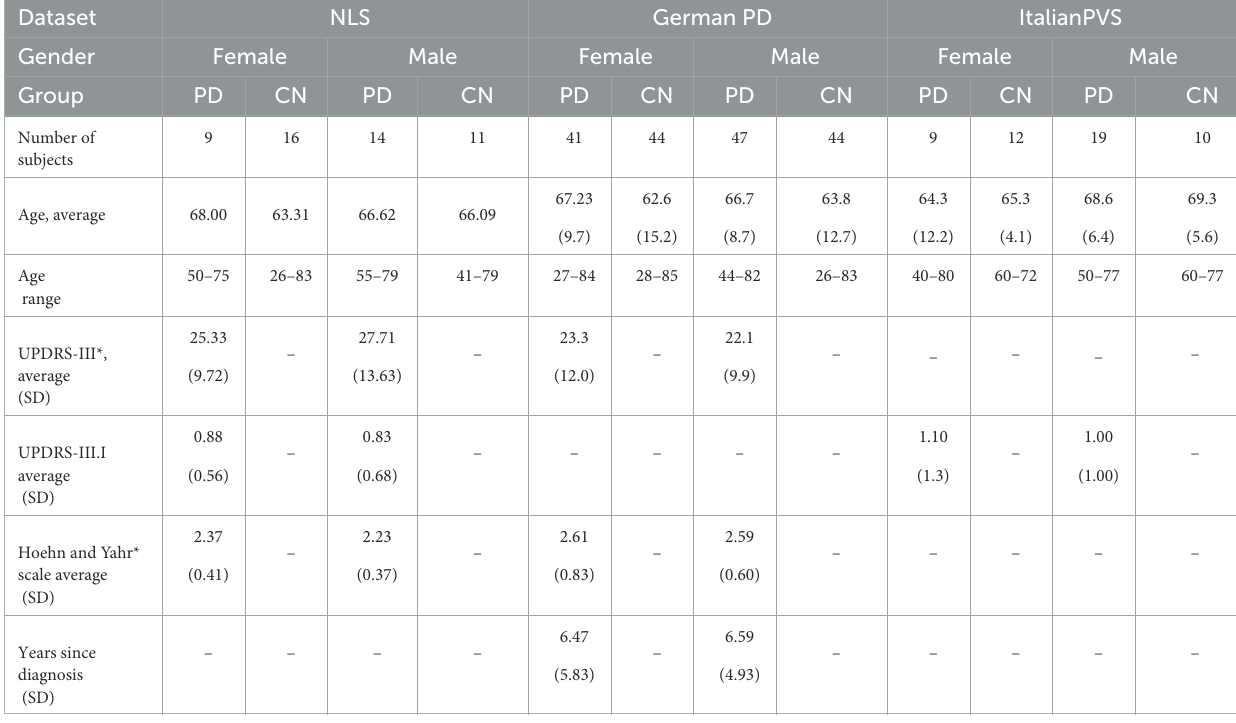
TABLE 2 Demographic and disease severity statistics of NLS, GermanPD, and ItalianPVS data sets. Dataset